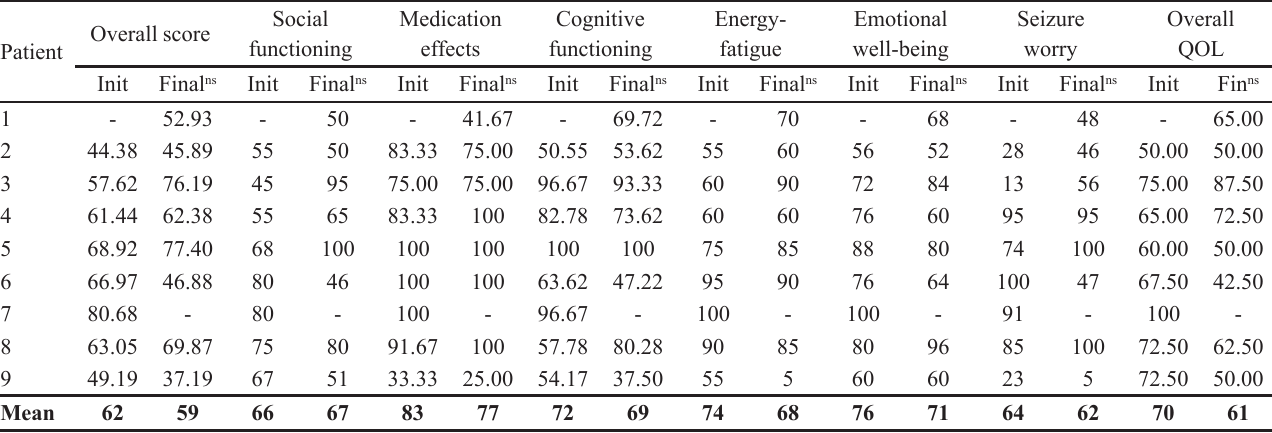
TABLE III - Results (initial versus final) on QOLIE-31 (total and domains) for formulation